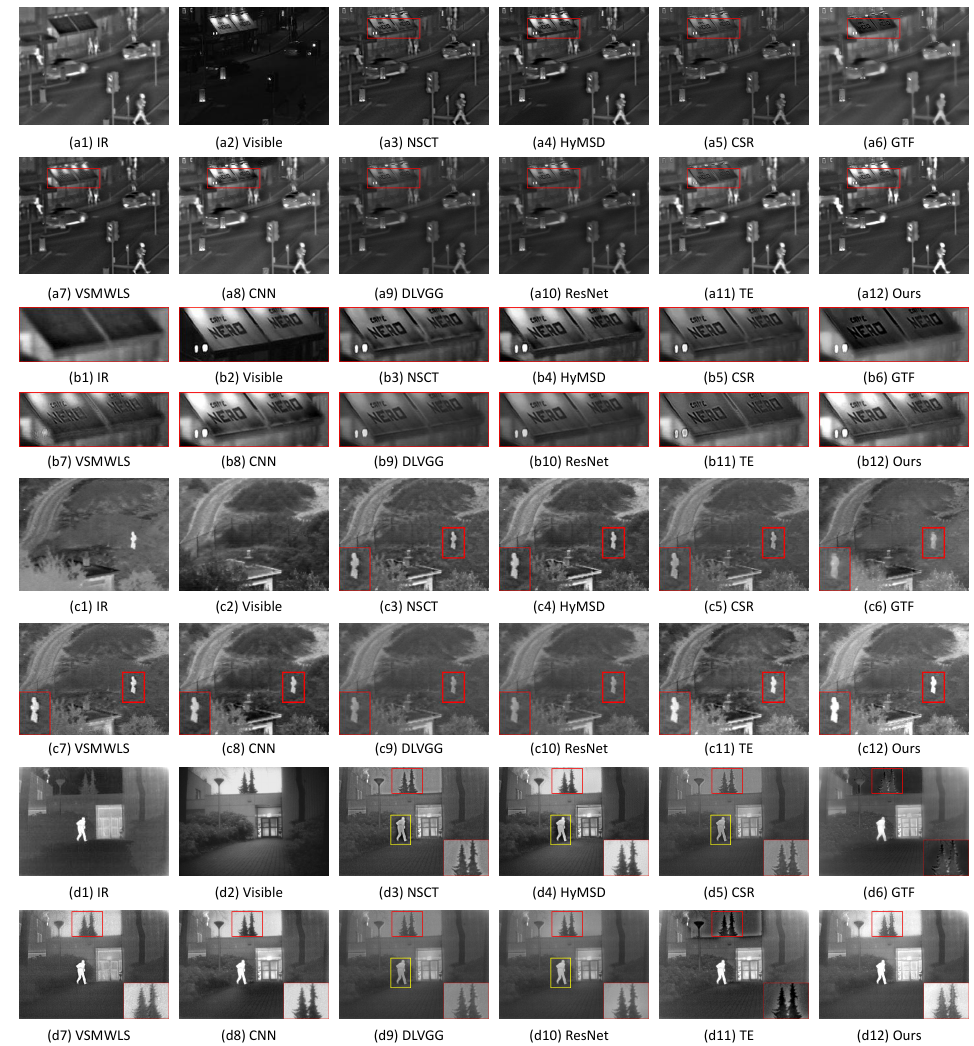
Figure 8. Fusion performance of various methods on the image pairs. From top to bottom: ‘Road ’, close-up view of ‘NERO’, ‘Camp’, and